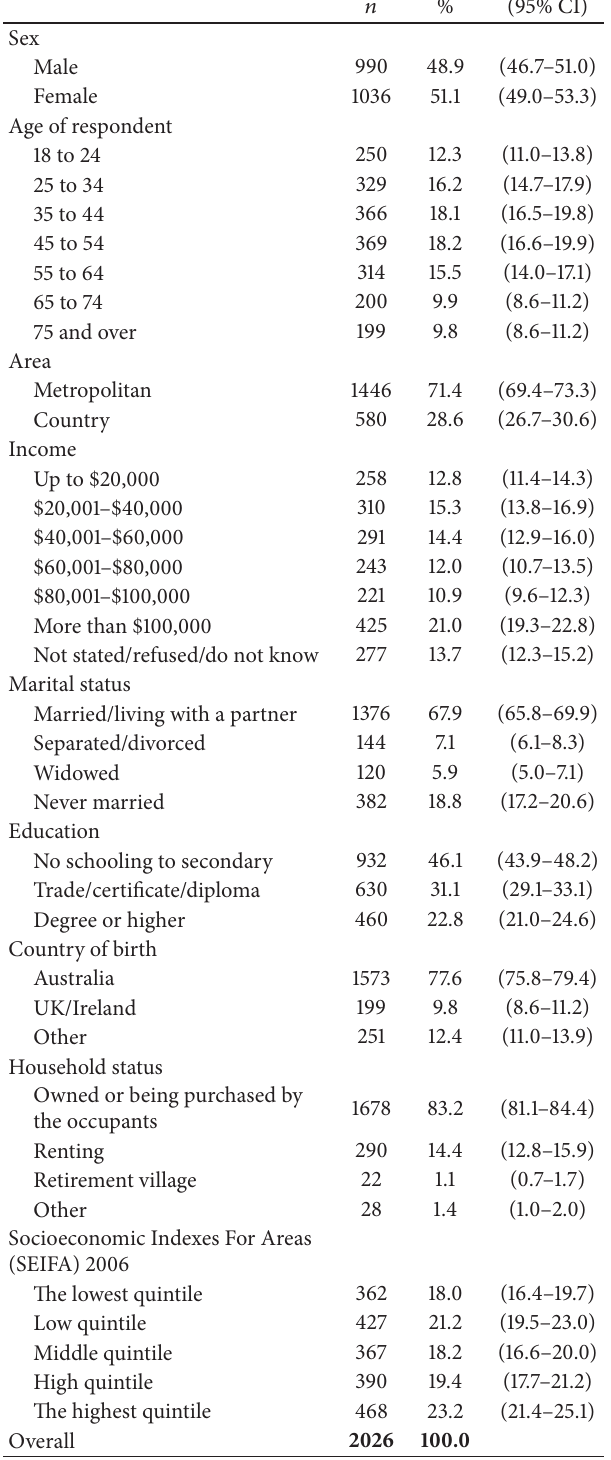
Table 1: Demographic characteristics of respondents. Table 2: Demographic characteristics of children in the household for whom data were